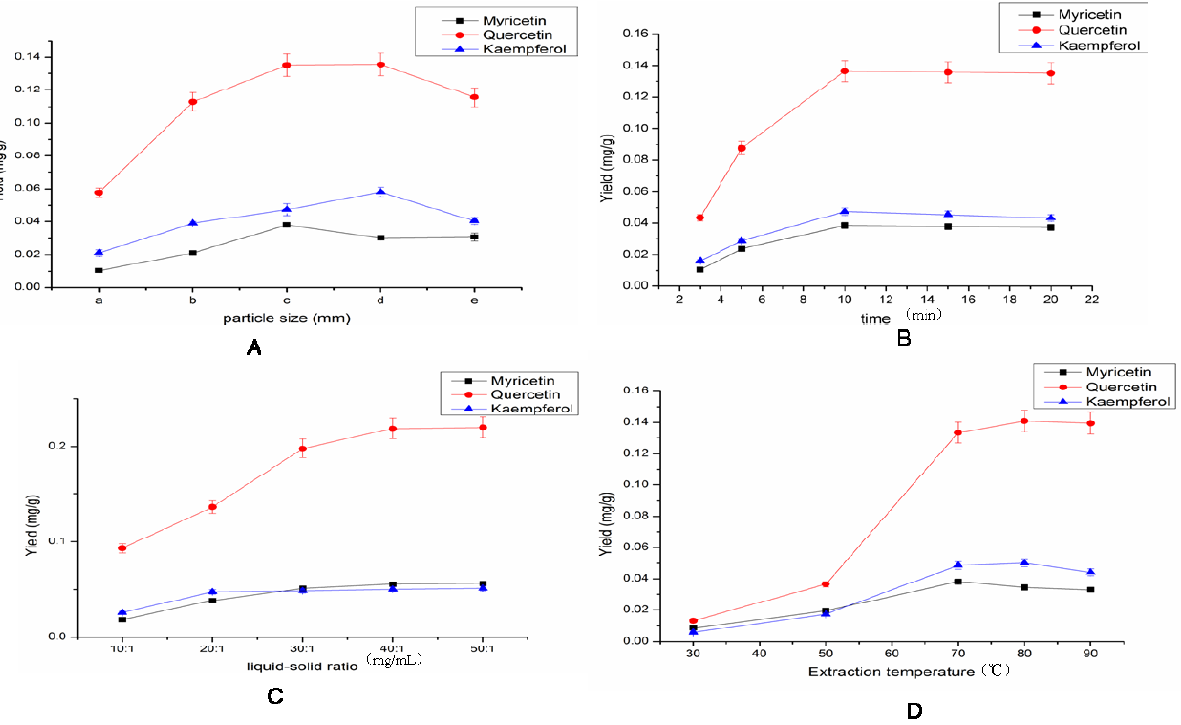
Figure 4. Effect of different factors on flavonoid extraction yields. ( A ) Effect of different particle size on flavonoids extraction yields (extraction time: 10 min; S/L ratio: 1:20; extraction temperature: 70 °C; HCl: 0.8 mol/L). ( B ) Effect of different time on flavonoids extraction yields (particle size : 0.30 to 0.45 mm; S/L ratio: 1:20; extraction temperature: 70 °C; HCl: 0.8 mol/L). ( C ) Effect of different S/L ratio on flavonoid extraction yields (extraction time: 10 min; particle size: 0.30 to 0.45 mm; extraction temperature: 70 °C; HCl: 0.8 mol/L). ( D ) Effect of different extraction temperatures on flavonoid extraction yields (S/L ratio: 1:20; extraction time: 10 min; particle size: 0.30 to 0.45 mm; HCl: 0.8